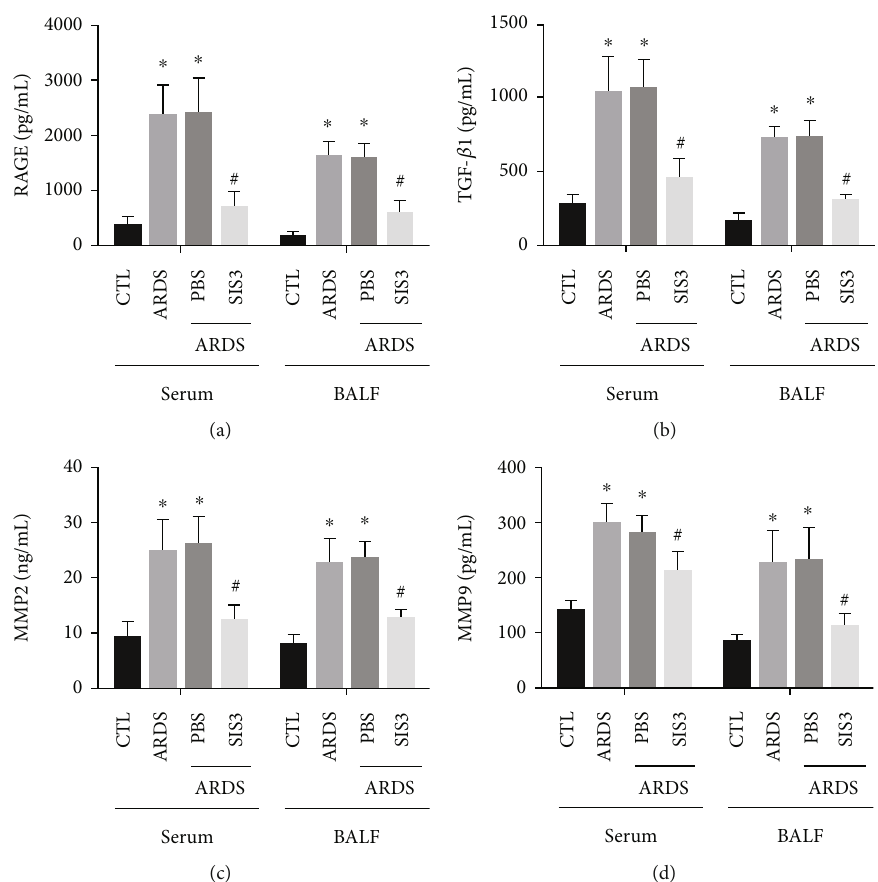
Figure 6: SIS3 pretreatment prevented the reduction of the expression of RAGE, TGF- β 1, MMP2, and MMP9 in LPS-induced ARDS. The e ff ects of SIS3 on the protein expression levels of (a) RAGE, (b) TGF- β 1, (c) MMP2, and (d) MMP9 in the BALF and sera of the ARDS rats were determined using ELISA. The results demonstrated that the levels of RAGE, TGF- β 1, MMP2, and MMP9 proteins were signi fi cantly higher in the ARDS group than in the control group, while the levels of RAGE, TGF- β 1, MMP2, and MMP9 in the SIS3 group were lower than those in the ARDS group. The protein levels of RAGE, TGF- β 1, MMP2, and MMP9 in LPS-administered pretreatment with PBS were not di ff erent from those of the ARDS group. The data are presented as the means ± SD of three independent experiments in triplicate ( n = 10 ). ★ P < 0 : 05 vs. CTL; # P < 0 : 05 vs. ARDS.